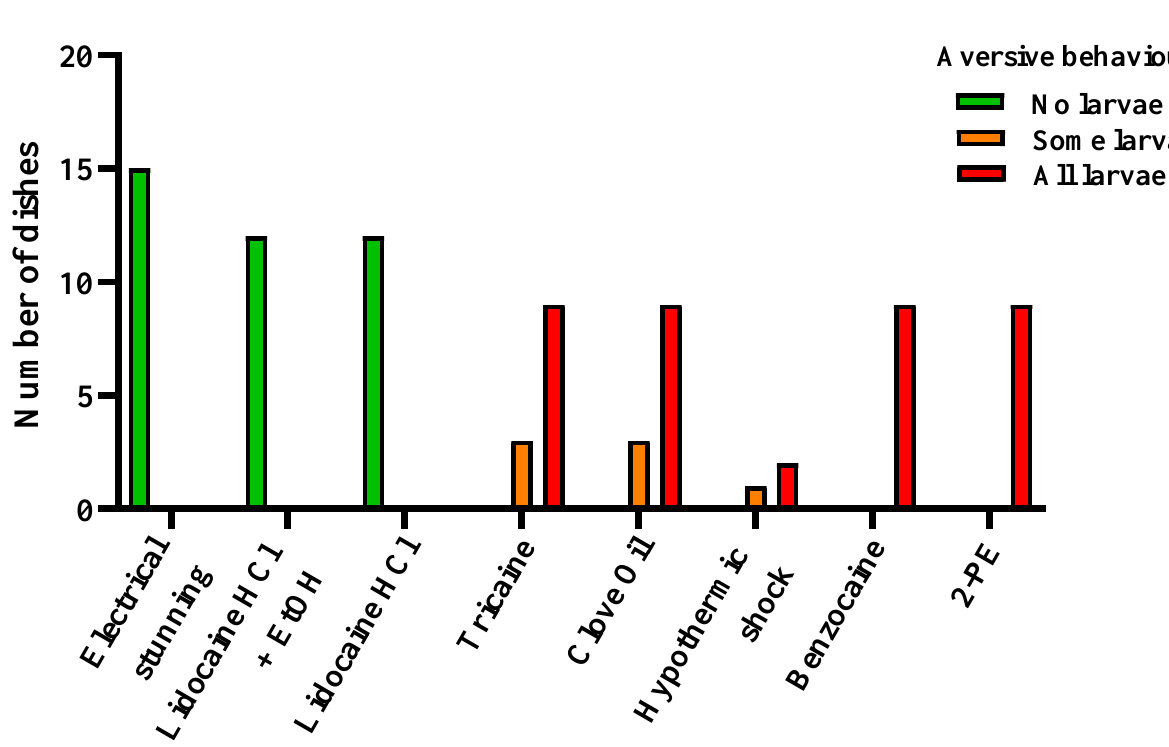
Figure 6. Aversive behavior in zebrafish larvae (4 days post fertilization) during electrical stunning, anesthetic overdose, and hypothermic shock, presented as result per dish. Each experimental dish ( n = 3–15 per treatment) contained 10–15 larvae. Dishes were scored as “No larvae”, “Some larvae”, or “All larvae” depending on the proportion of the larvae displaying aversive behavior.